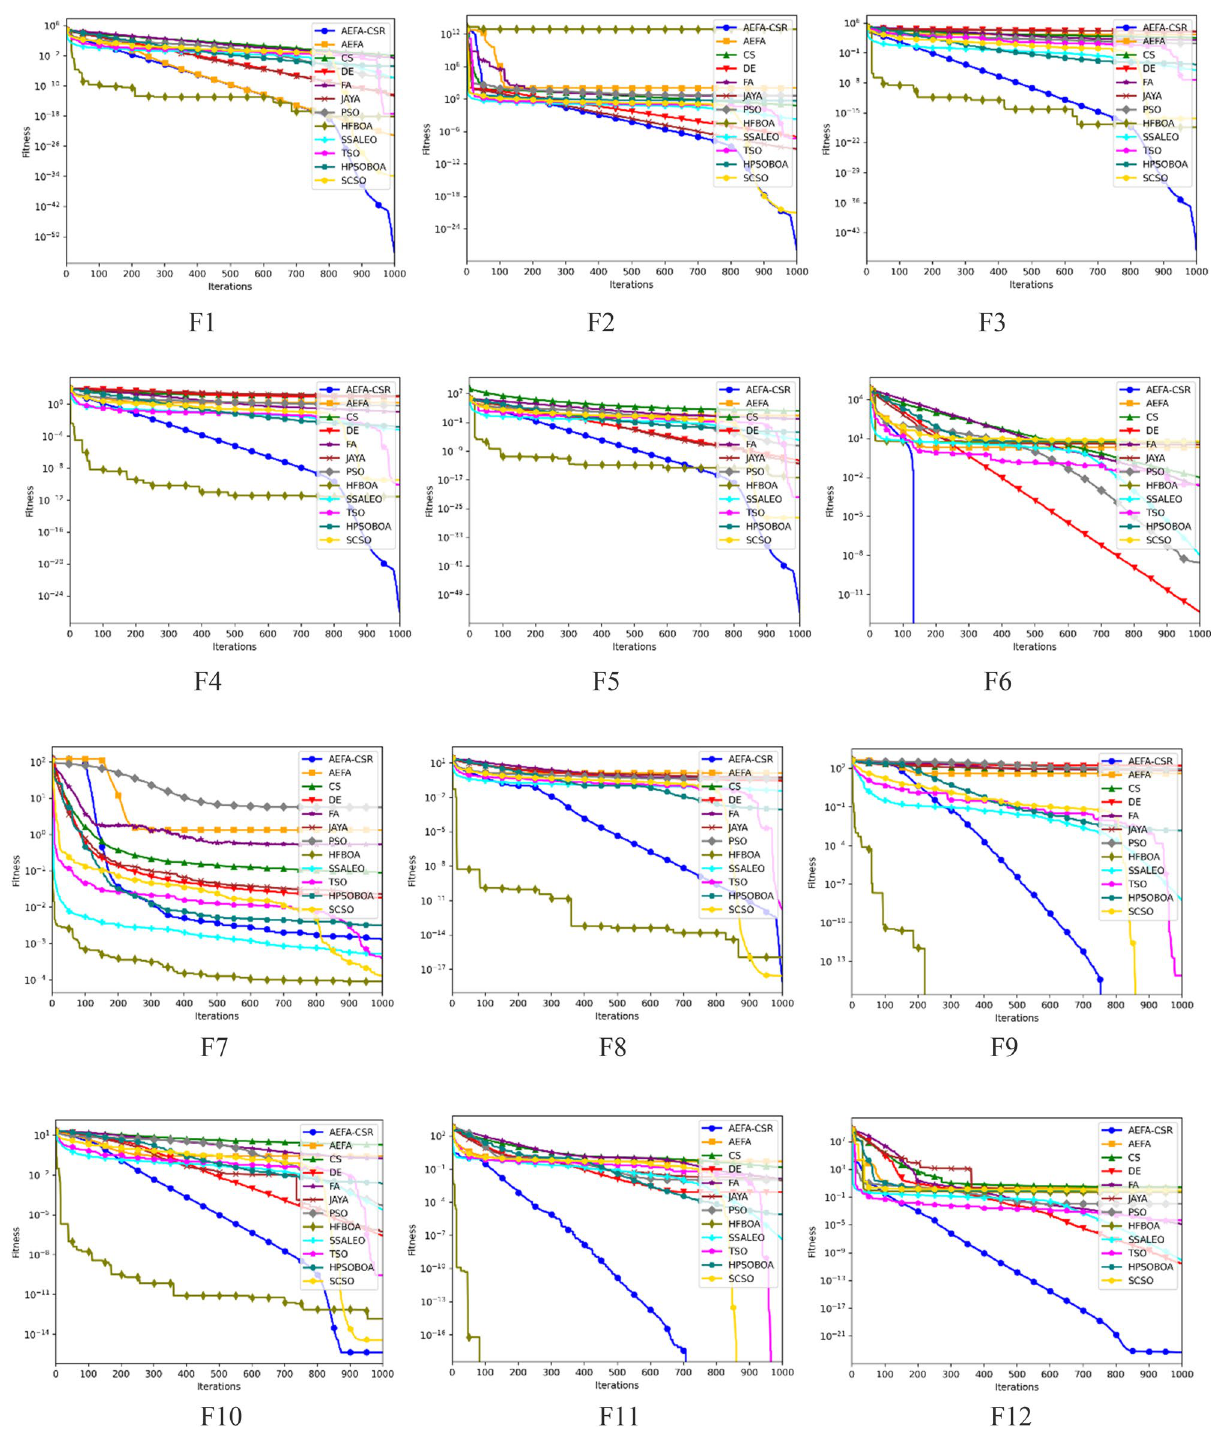
Figure 3. Convergence trajectory with dimension = 30